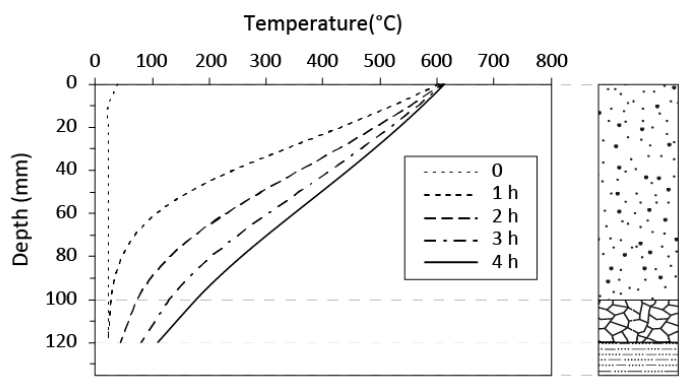
Figure 13. Temperature distribution in a green roof assembly installed over a wood deck and without gypsum board.